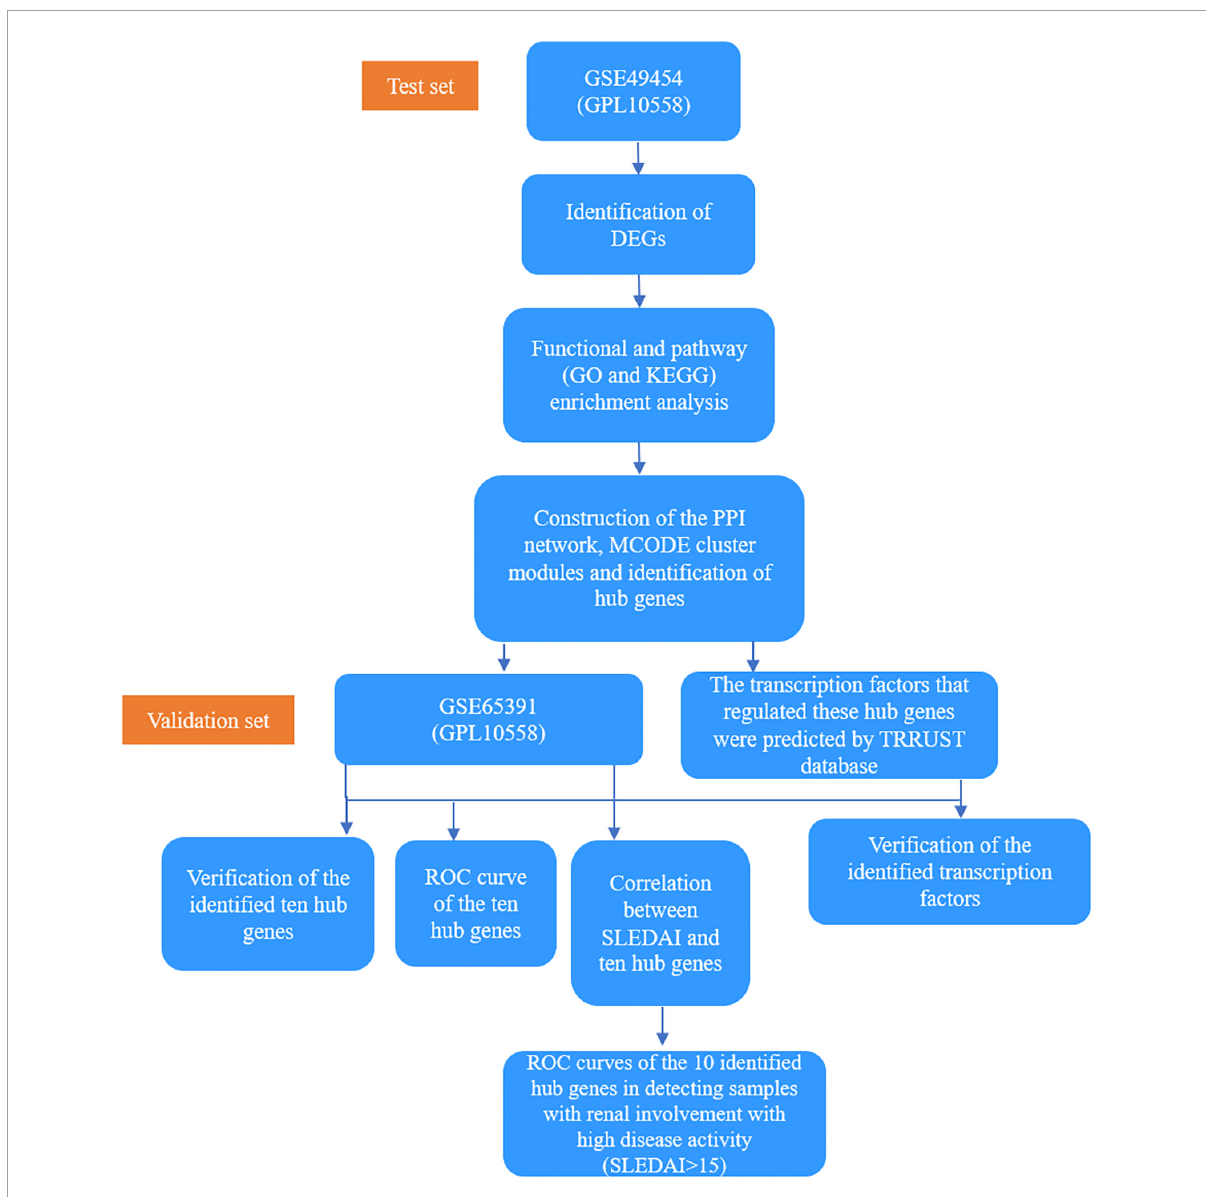
FIGURE1 A flowchart of the overall